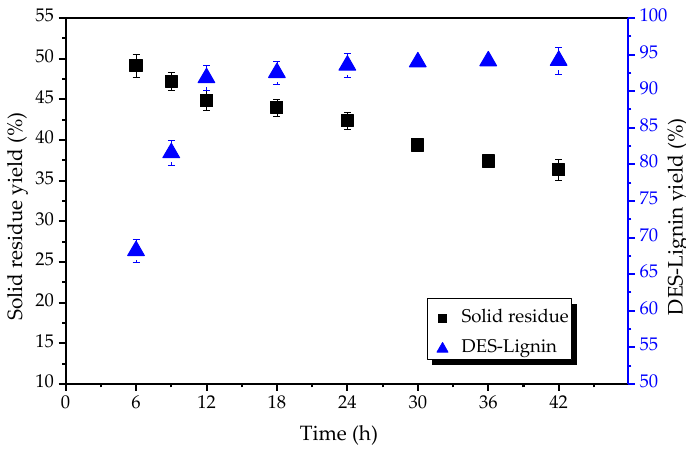
Figure 3. Solid residue yield and DES-Lignin yield varying with treatment time after ChCl-Lac (molar ratio 1:10) treatment at a treatment temperature of 120 °C.